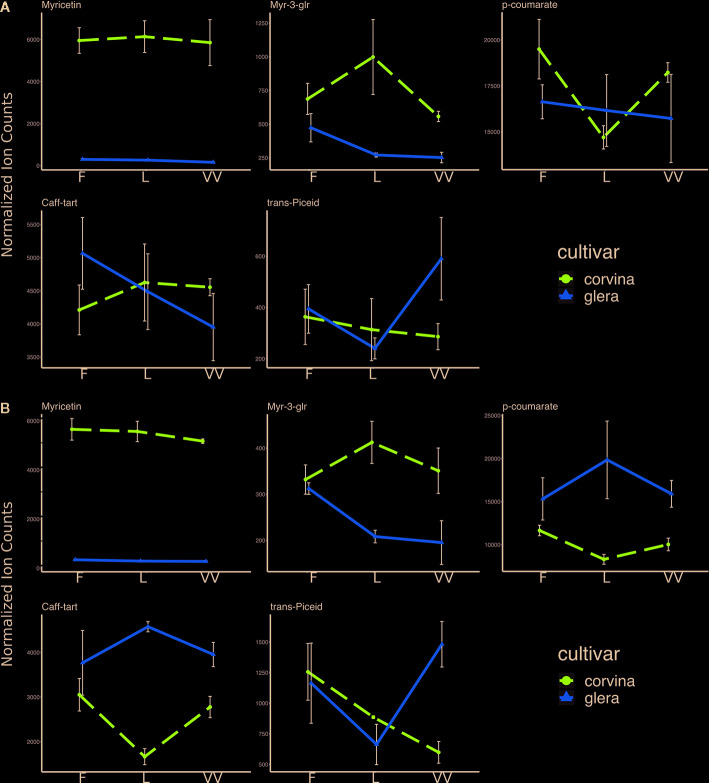
Significant metabolites modulated by Genotype × Environment interactions in Glera and Corvina. Levels represent relative abundance based on ion counts. Purple lines represent Corvina variety, and yellow lines represent Glera variety. (A) G×E interactions at complete-véraison (CV) stage; (B) G×E interaction at ripening (R) stage. Error bars indicate standard error (n = 3).